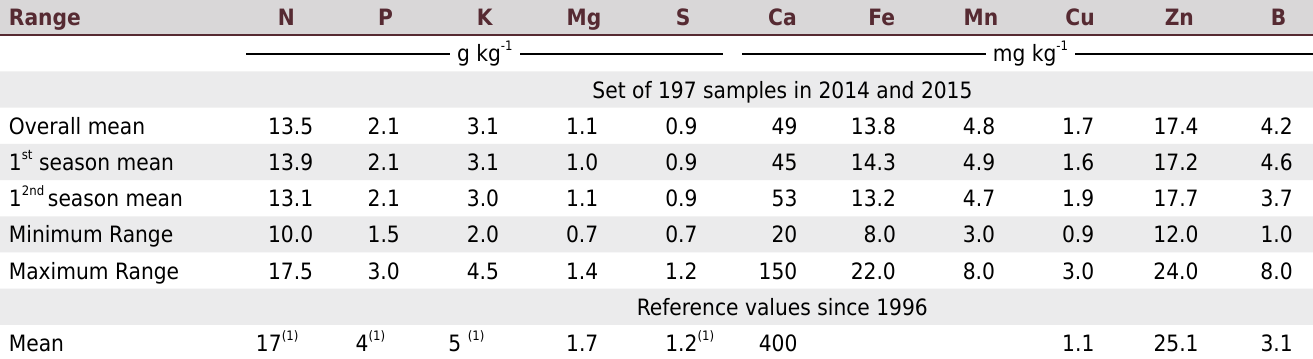
Table 4. Overall and subdivided mean nutrient contents in corn grains for the first and second growing seasons, minimum-maximum intervals, and reference values Range N P K Mg